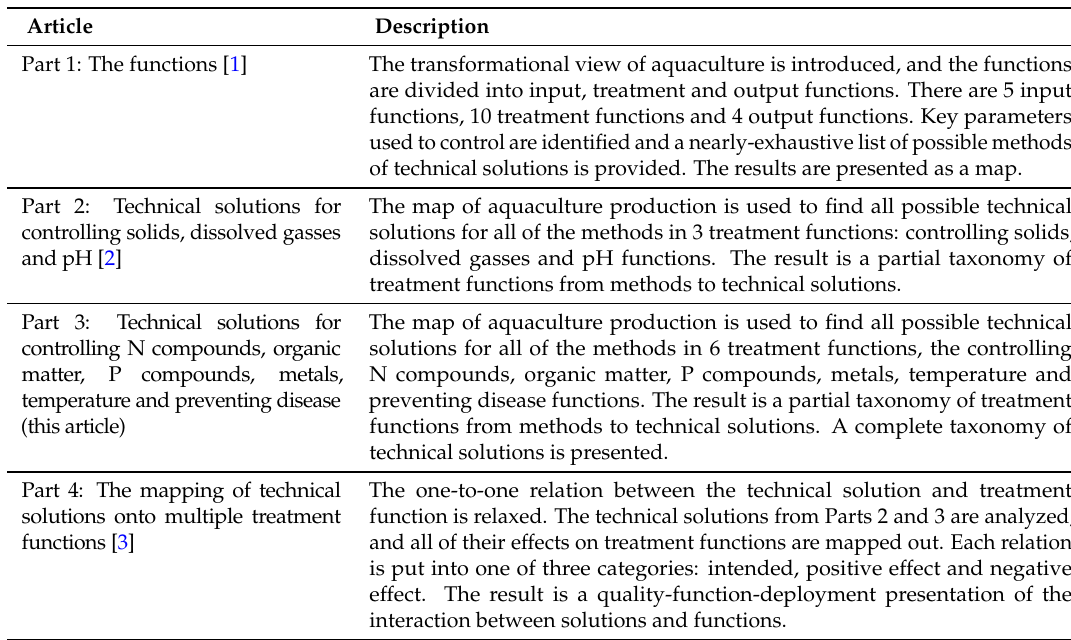
Table 1. Overview of how the research is divided into